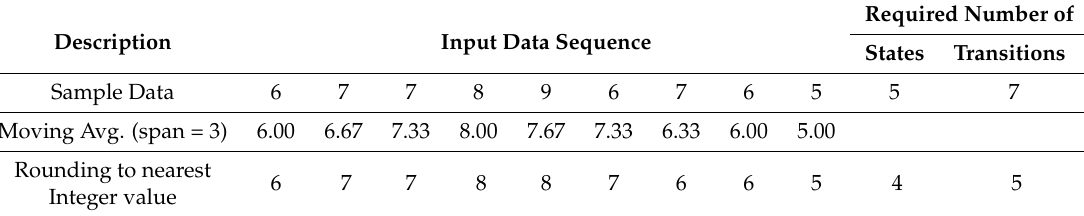
Table 2. Illustration of smoothing filter operation on a sample occupancy sequence.